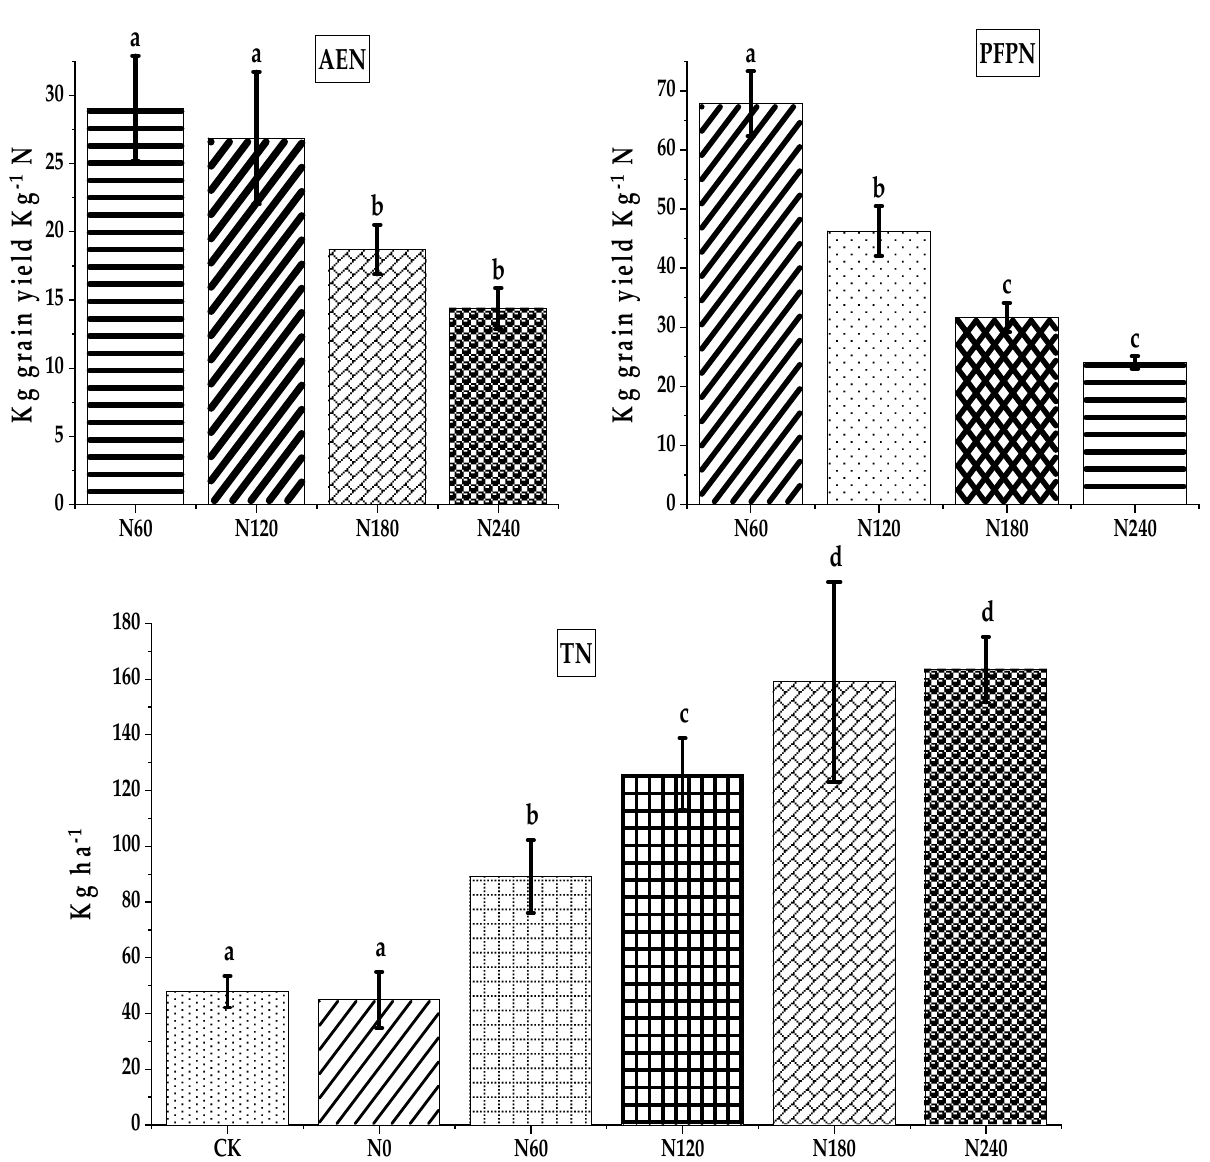
Figure 6. Total nitrogen uptake, agronomic use efficiency and partial factor productivity of N as influenced by different levels of N. TN; total nitrogen, AEN; agronomic N use efficiency (kg grain kg − 1 N), PFPN; partial factor productivity of N (kg grain kg − 1 N), CK; control treatment, N0; 0 kg ha − 1 N, N60; 60 kg ha − 1 N, N120; 120 kg ha − 1 N, N180; 180 kg ha − 1 N, N240; 240 kg ha − 1 N, the mean values with similar letters across the treatments denote a non-significant effect ( p ≤ 0.05). Table 3. Partial economic analysis of different treatments estimated for a hectare of land (USD 1: 116.39 NPR).